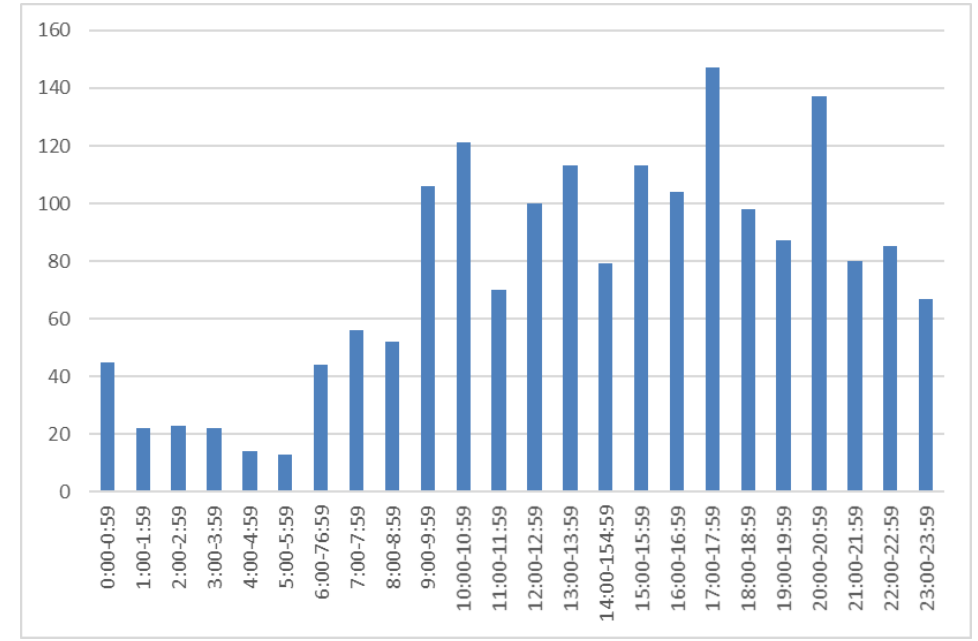
Figure 1. The specific time (h) of each restraint that occurred on the wards ( f = 1798).